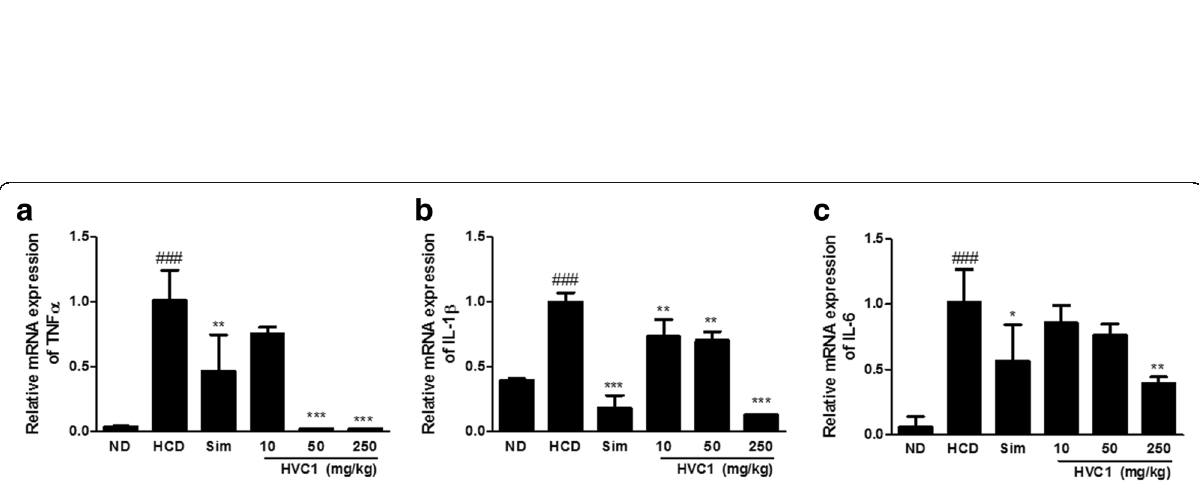
Fig. 5 Inhibitory effects of HVC1 on mRNA expression of inflammatory cytokines in HCD induced LDLR − / − mice. Inflammatory cytokine genes mRNA levels were analyzed by real-time PCR analysis. ( a ) TNF- α , ( b ) IL-1 β , ( c ) IL-6.Total RNA was subjected to real-time PCR as described in the Methods section. Values represent mean ± S.D. of three independent experiments (significant as compared to HCD, * p < 0.05, ** p < 0.01, *** p < 0.001, significant as compared to ND, ### p <